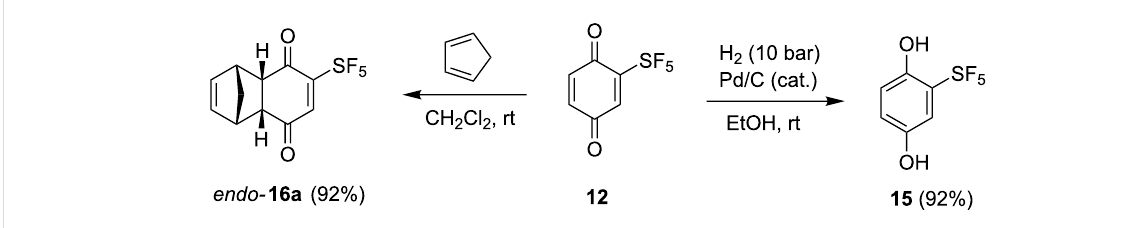
Scheme 5: Catalytic hydrogenation and Diels–Alder reaction of benzoquinone 12 .